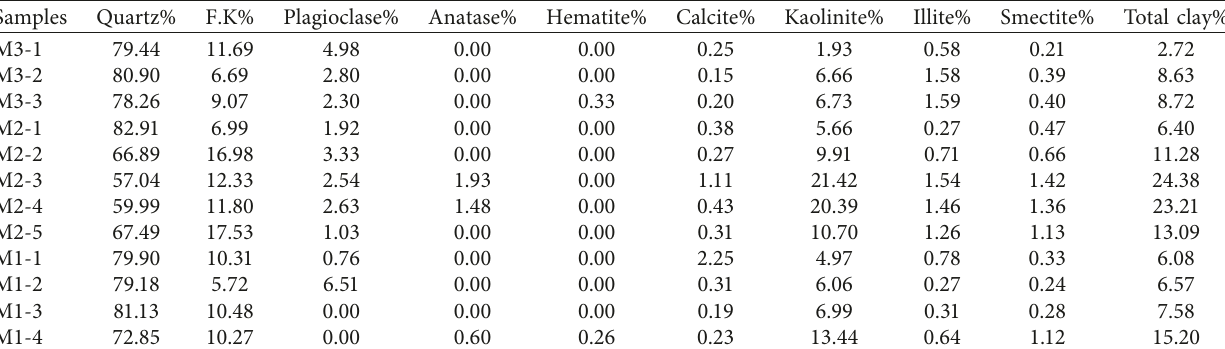
Table 1: Mineralogical composition of the studied soils.